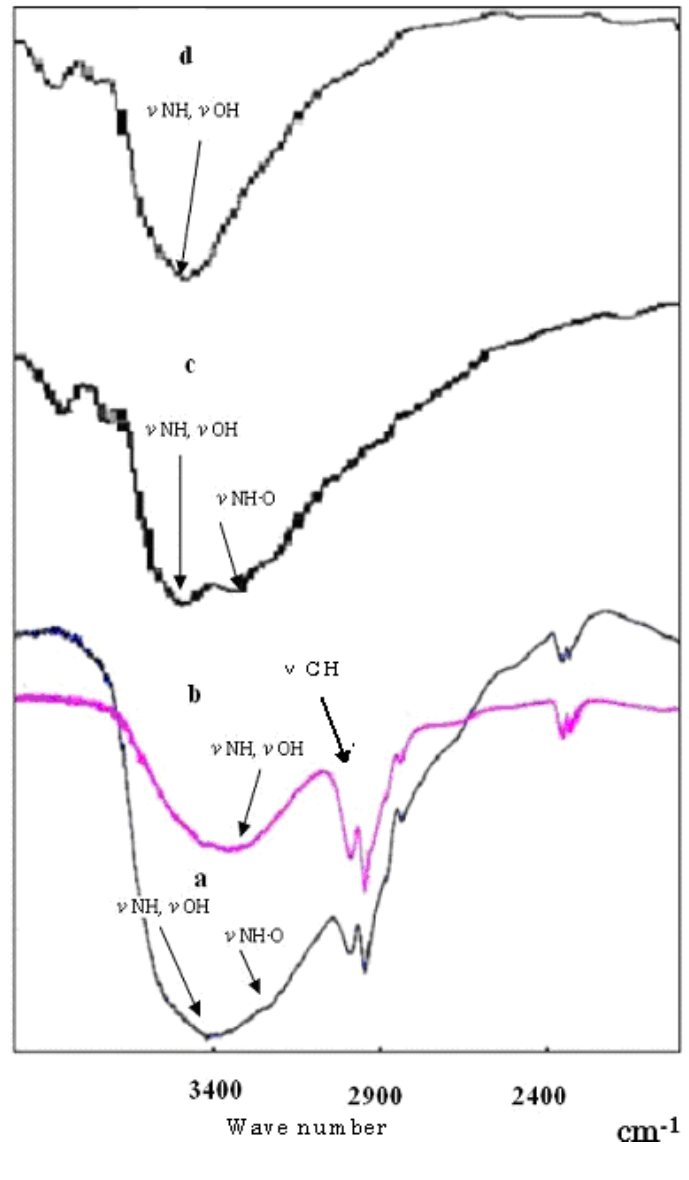
Infra-Red absorption spectra: a, complex of DDMC/DNA; b, DDMC; c, complex of DEAE-dextran/DNA; d,